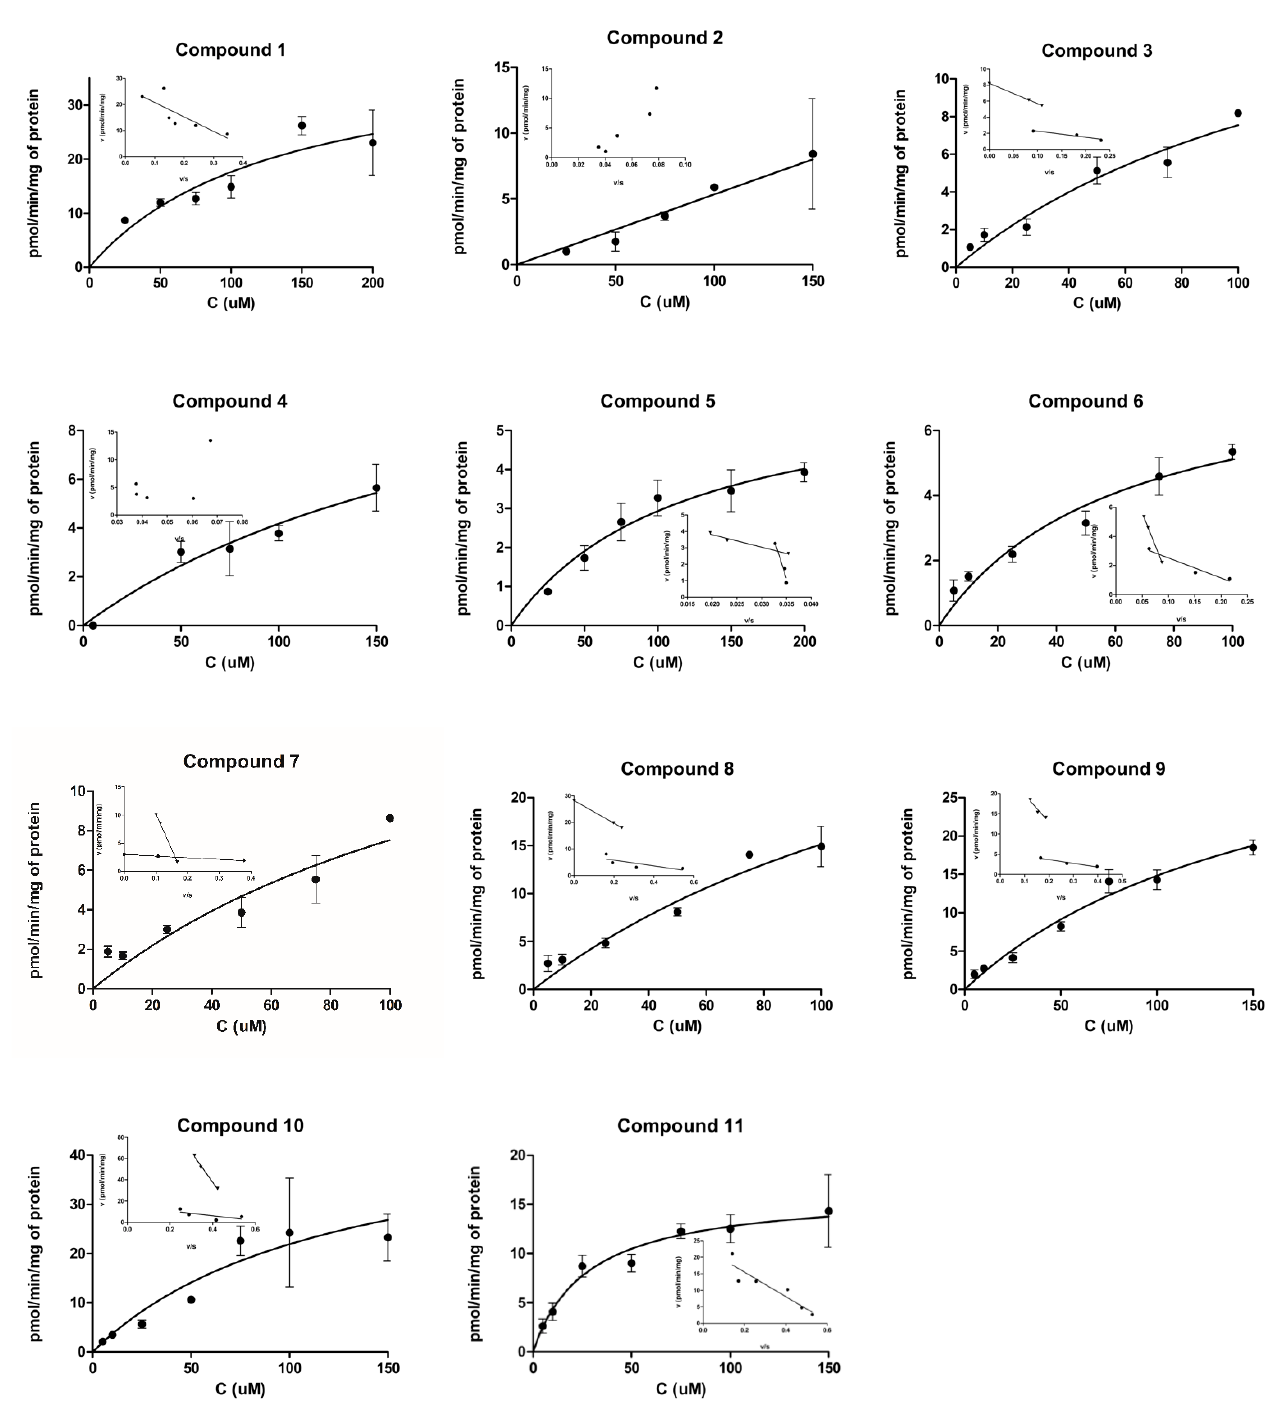
Figure 2. Cellular uptake of compounds 1 – 11 into the MCF-7 cells over a concentration range of 5–200 µ M and the Eadie-Hofstee plots for transporter-mediated uptake (insets). The data is presented as mean ± SD ( n = 3).